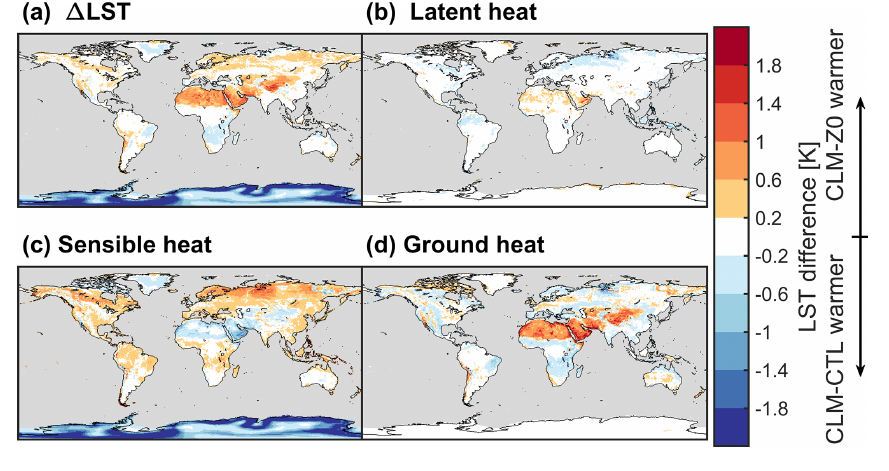
Figure A3. As Fig. A2 but at 01:30 local solar time.